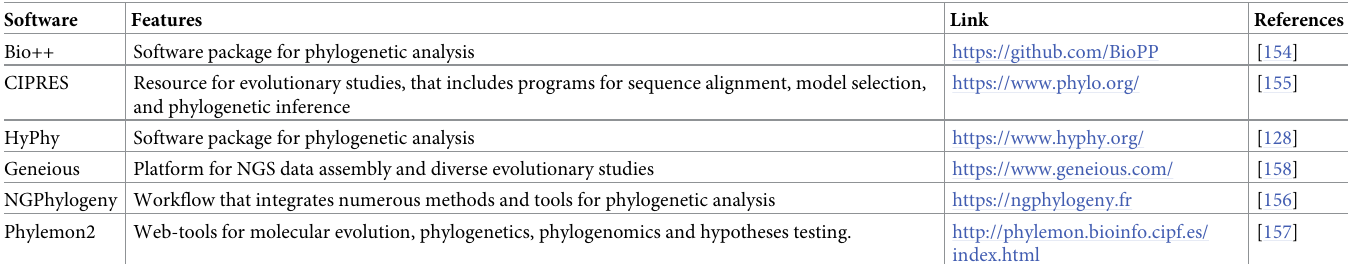
Table 9. List of packages for phylogenetic analysis and evolutionary